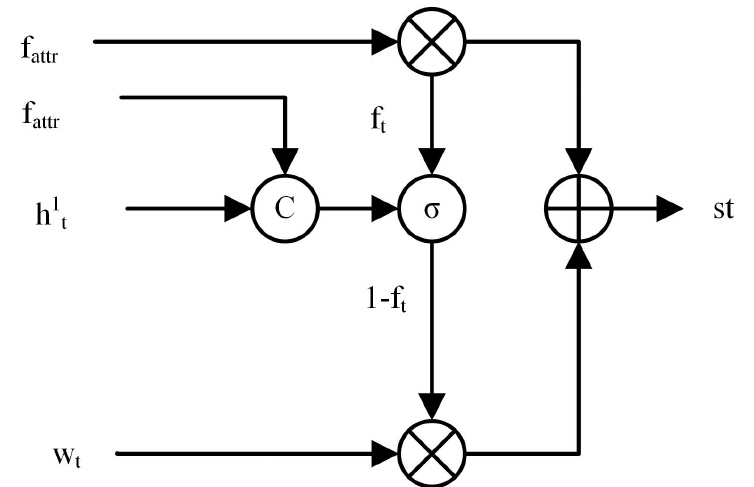
Figure 4. Overview of the Text-Enhance module. f attr represents the entity features of the image ground object. w t represents the word to be input at t times. The Text-Enhance module uses the correlation between f attr and w t to achieve enhancement of the ground object text